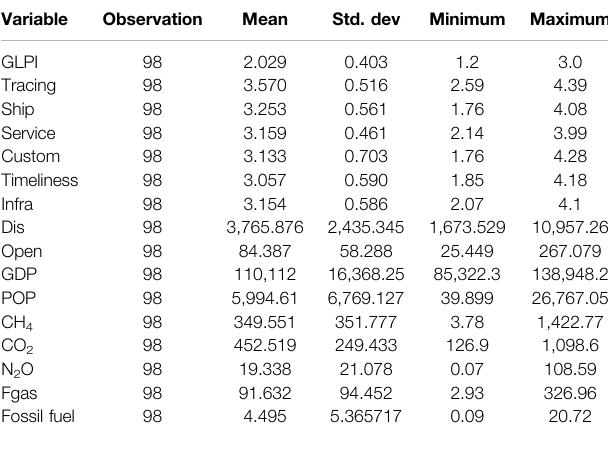
TABLE 5 | Summary statistics of the variable for RCEP sub-sample. Variable